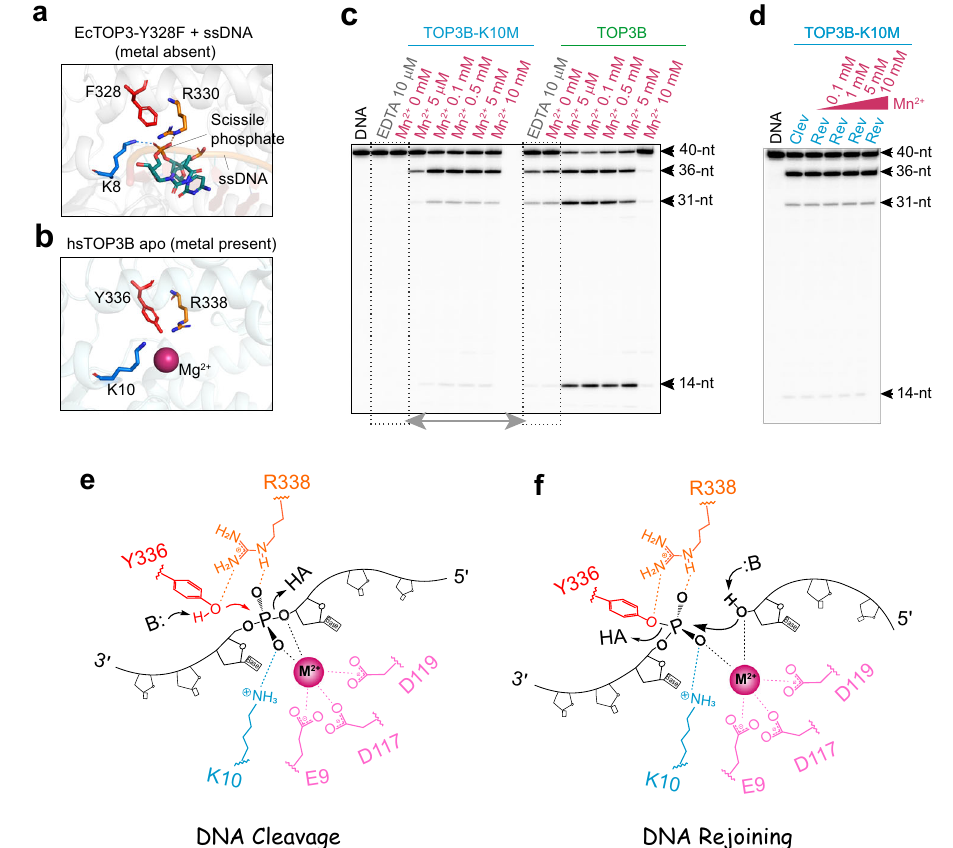
Fig.2|TOP3Blysine10(K10)isaconservedcatalyticresidueassistingdivalent cation-dependentDNAcleavage and requiredfor DNA rejoining. a Structureof Ec TOP3(PDBID:1i7D)showingtheinteractionbetweentheDNAscissilephosphate and the conserved Lysine residue K8 (blue dotted line) in the absence of divalent cation. Key residues for catalysis including the Tyrosine substitute F328 and Argi- nine R330 are shown as sticks. b Catalytic site of hsTOP3B apo structure (PDB ID: 5gvc)inthepresenceofaMg 2+ ionshowingtheconservedLysineK10andotherkey catalytic residues. c DNA cleavage assay with WT TOP3B and mutant TOP3B-K10M without divalent cation and with the indicated concentrations of Mn 2+ . Dotted boxesanddouble-headedarrowhighlightthecomparisonofDNAcleavageactivity between the mutant and the WT enzyme without divalent-metal addition. d DNA cleavage and lack of reversal with TOP3B-K10M in the presence of Mn 2+ (0.1 – 10mM). DNA cleavage products were collected after 30min incubation. Reversal assays were conducted by adding high salt and indicated amount of Mn 2+